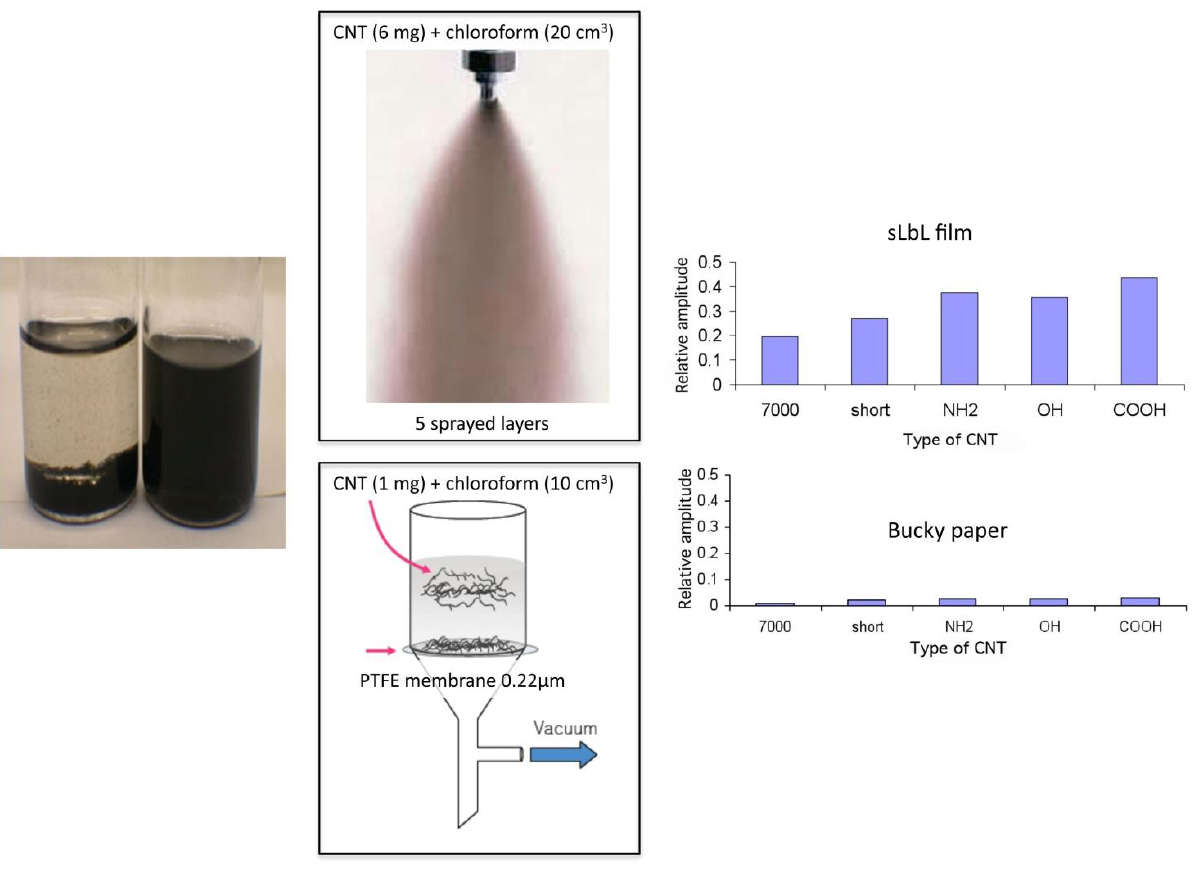
Figure 1. Comparison of the CNT random network transducers’ response to methanol vapor depending on their form, i.e. , 5-layer film sprayed layer-by-layer ( top ) or bucky paper made under vacuum ( bottom ). sLbL, sprayed